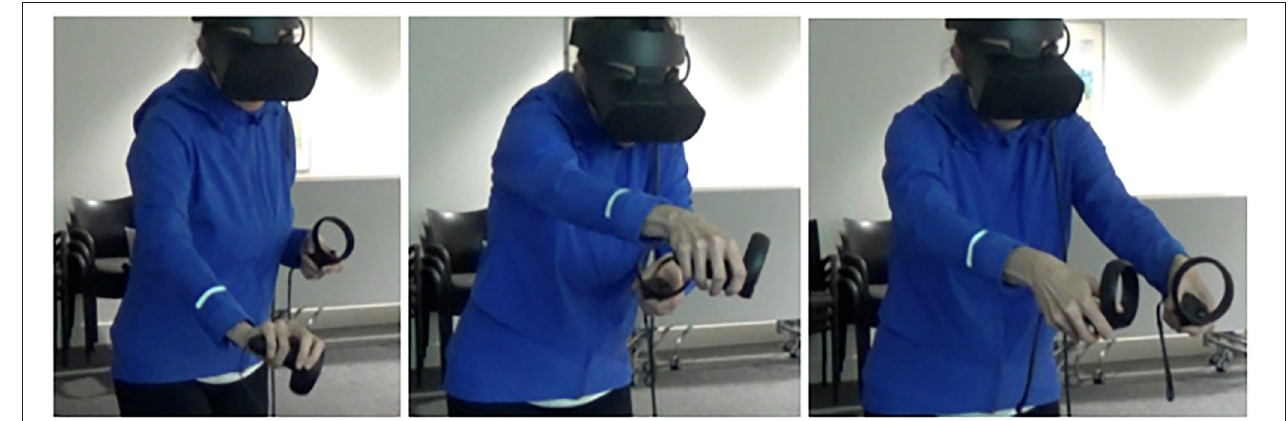
FIGURE 4 | Hand and arm positioning when holding, touching and manipulating